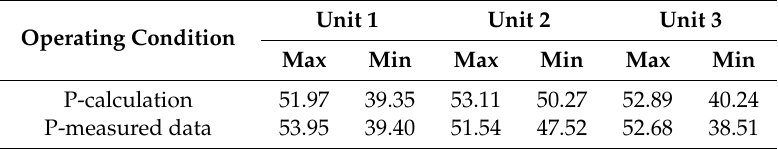
Table 2. Monitored data from the three